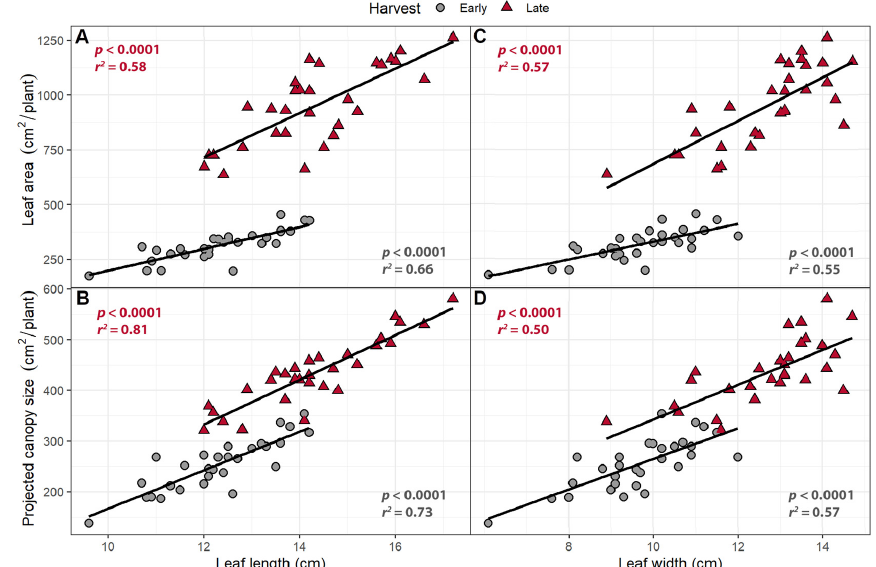
Figure 2. ( A ) The correlation between ( A ) leaf length and leaf area; ( B ) leaf length and projected canopy size; ( C ) leaf width and leaf area, and ( D ) leaf width and projected canopy size. “Green Salad Bowl” lettuce plants were grown under a photosynthetic photon flux density of 207 ± 13 µmol m − 2 s − 1 supplemented with varying amounts of far-red. The early harvest occurred 16 days after germination, while the late harvest occurred 25 days after germination.